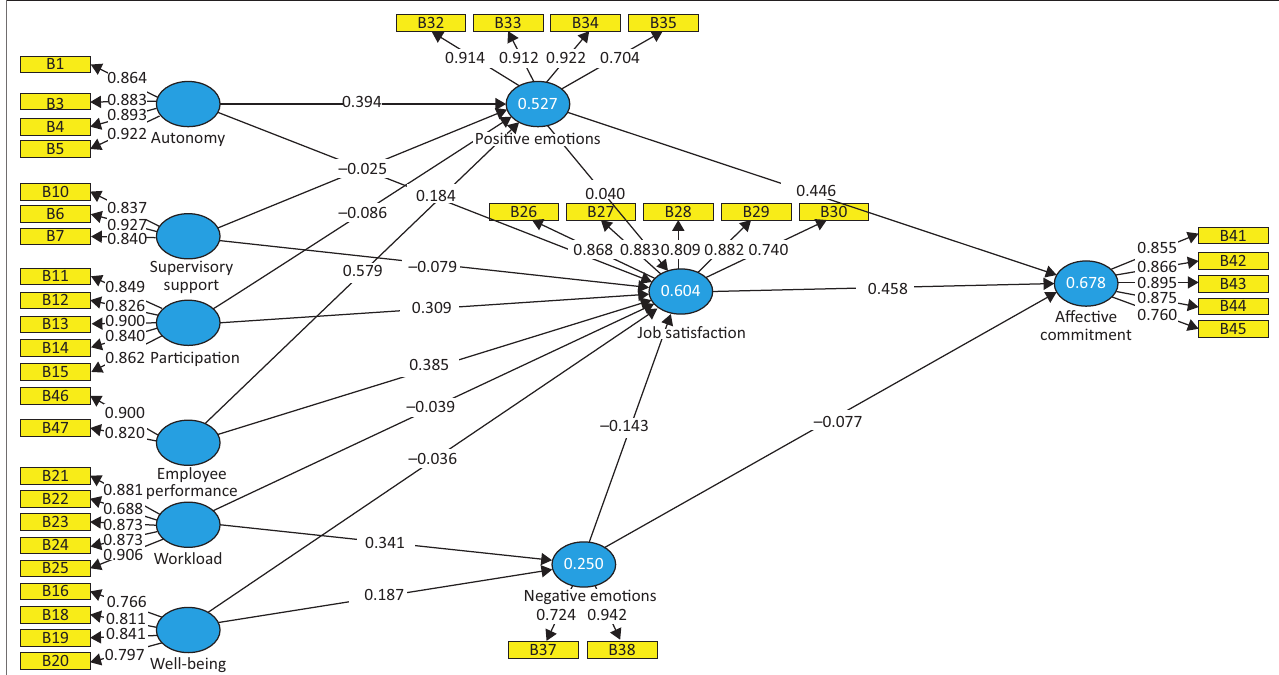
FIGURE 2: Study statistical